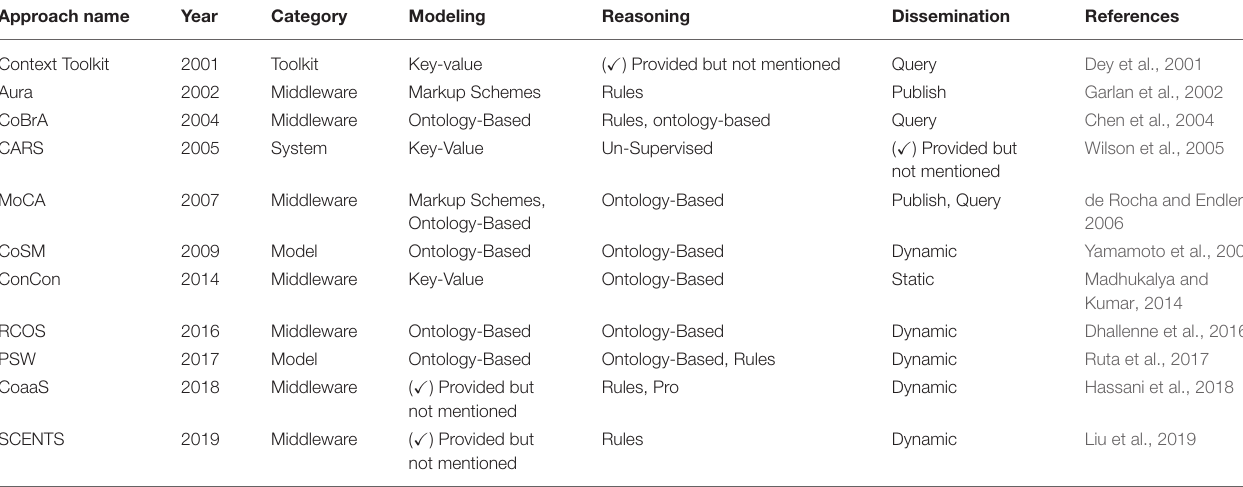
TABLE 4 | Comparison of context-awareness features of existing approaches.